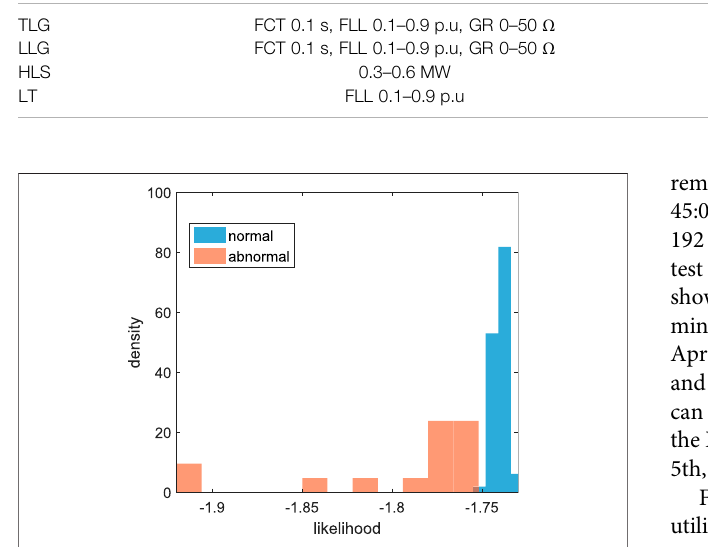
FIGURE 8 | Likelihood distributions of normal and abnormal